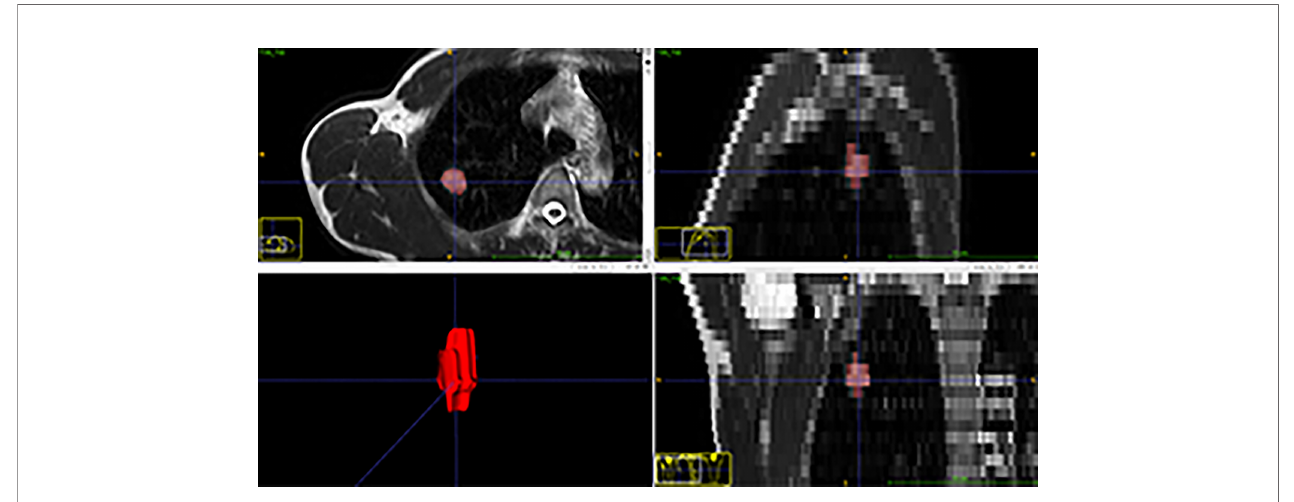
FIGURE 1 | Segmentation of a nodule in the upper right lobe on T2-weighted